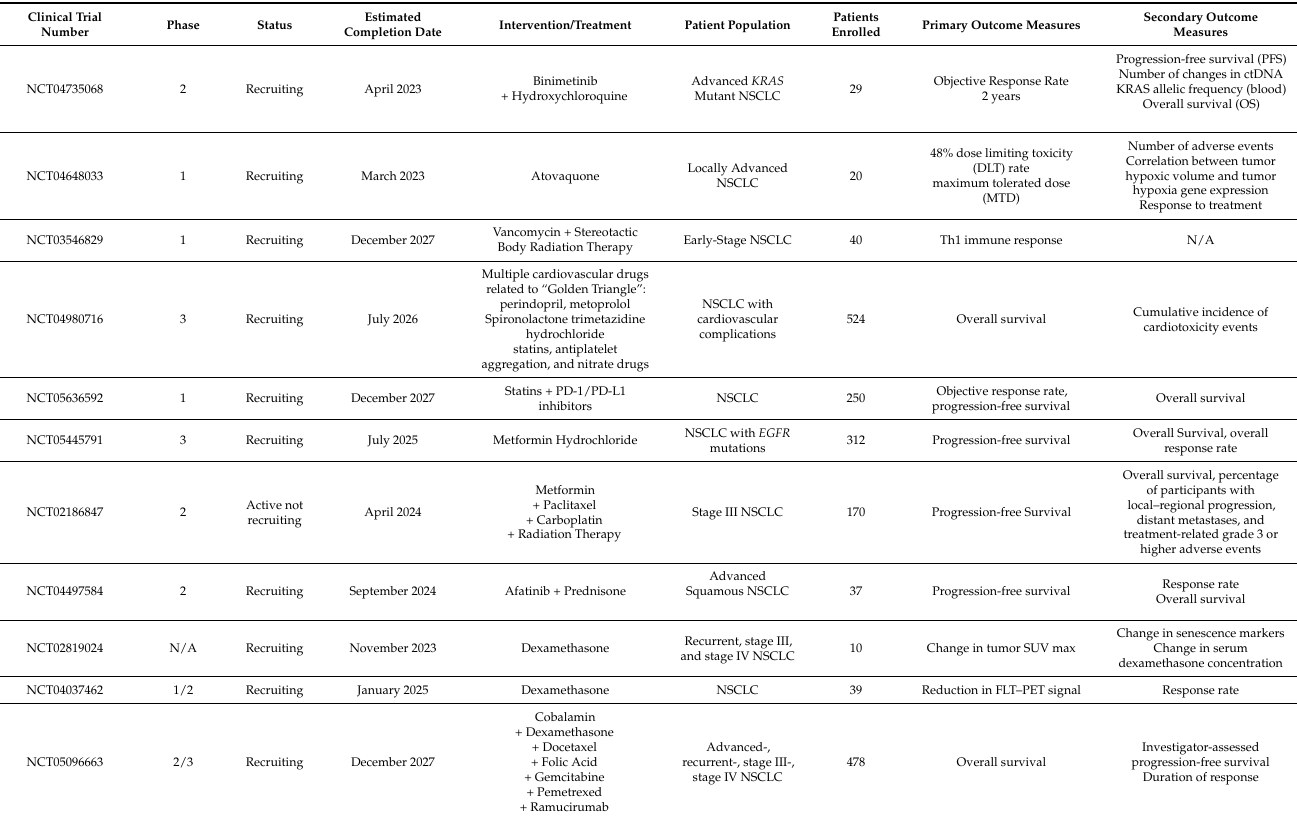
Table 2. Current clinical trials investigating repurposed drugs for the treatment of